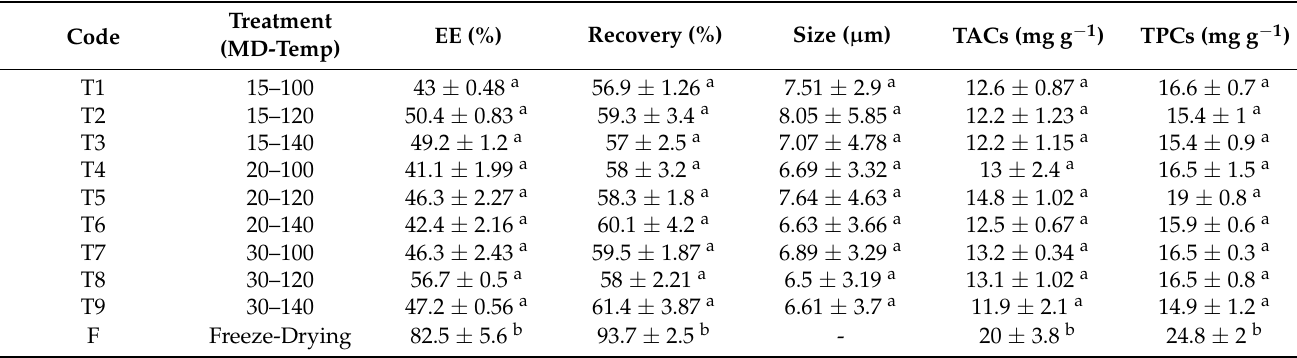
Table 1. Entrapment efficiency (EE), recovery, size of microcapsules, and quantification of phenolic compounds of different dried treatments.